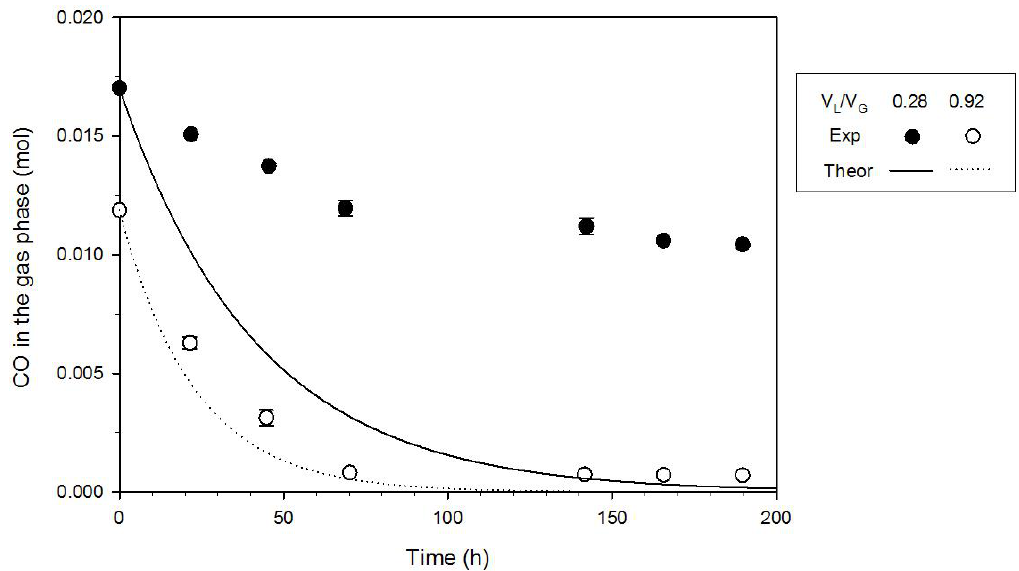
Figure 3. CO in the headspace vs. fermentation time. Initial P CO = 2 atm. Experimental data and plots of Equation (4).